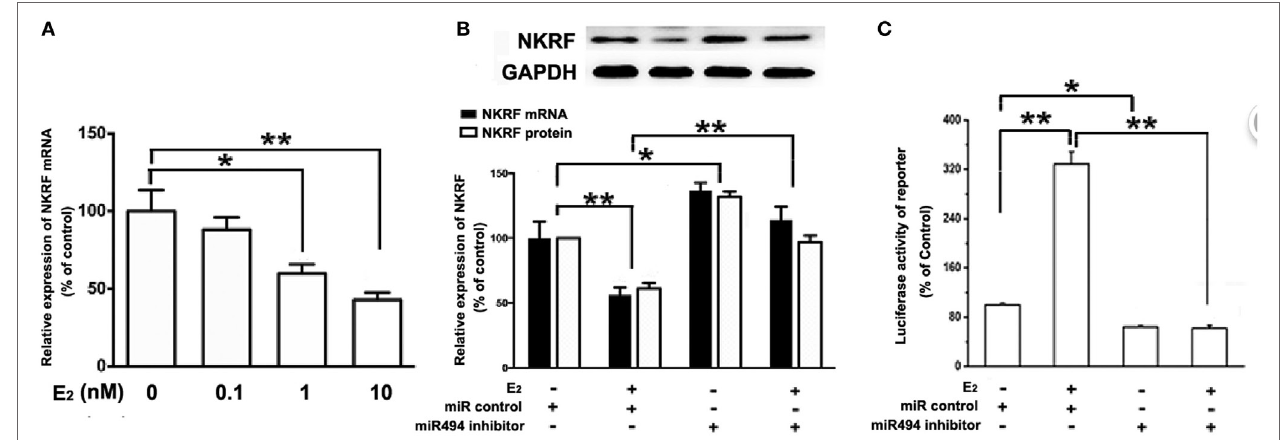
FigUre 5 | E 2 inhibits (NF- κ B) repressing factor (NKRF), thus activating NF- κ B through a miR-494-dependent mechanism. (a) H9c2 cells were stimulated with E 2 at indicated doses for 24 h. Quantitative real-time RT-PCR was used to determine NKRF mRNA expression in cardiomyocytes. (B) H9c2 cells were transfected with control microRNA (miR) or miR-494 inhibitor for 24 h and then treated with E 2 (10 nmol/L) for another 24 h. Quantitative real-time RT-PCR and western blot analysis were used to determine NKRF mRNA and protein expression in cardiomyocytes, respectively. (c) H9c2 co-transfected with 0.4 µg of pGL3 or pGL3-NF κ B reporter plasmids in the presence of miR control or miR-494 inhibitor (200 nM) for 24 h, and then treated with E 2 (10 nmol/L) for another 24 h. Luciferase activity was measured using dual-luciferase assay. All bar graphs represent mean ± SEM from four independent experiments. * P < 0.05, ** P <